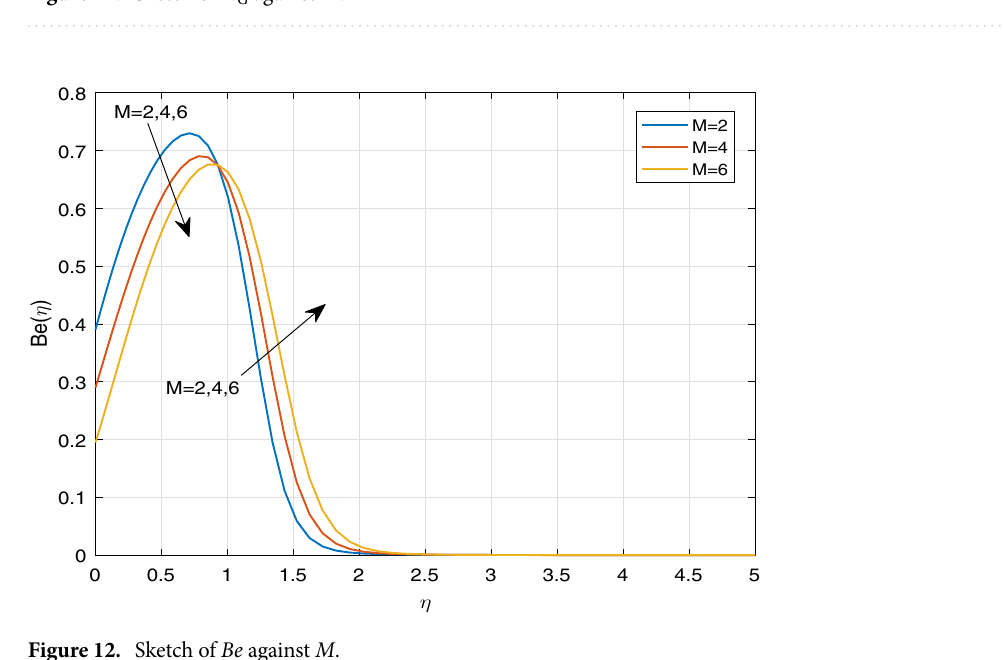
Figure 12. Sketch of Be against M